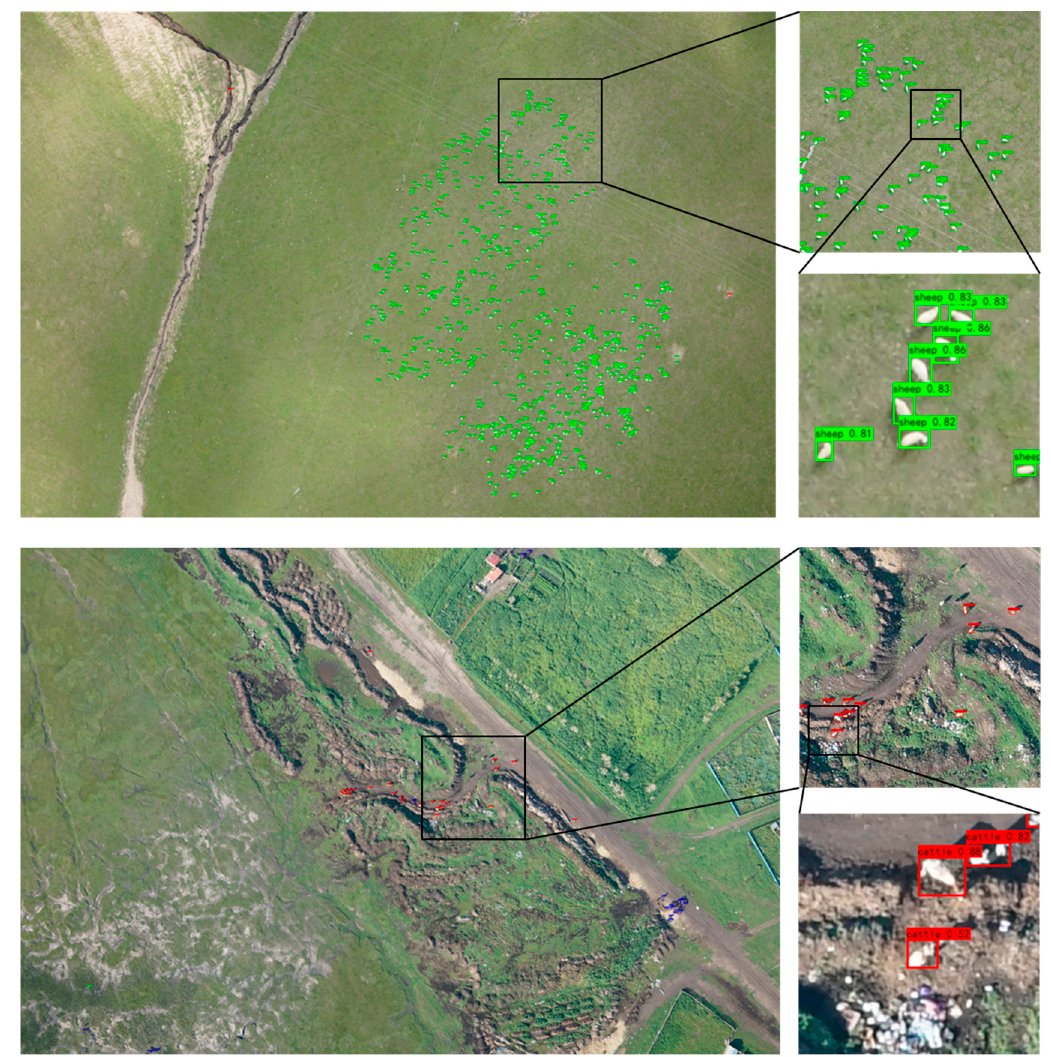
Figure 16. The result of the direct detection of the original image of the UAV.